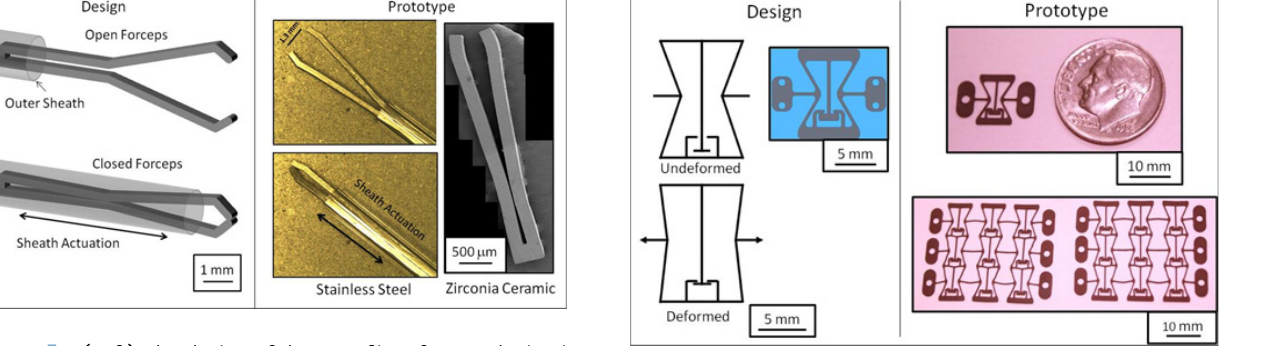
Figure 6. (Left) The design of contact-aided compliant cellular mechanisms is shown in both the undeformed and deformed cases. As the mechanism is deformed, contact occurs in the dash-pot struc- ture, resulting in a distribution of stresses throughout the device, allowing further elastic deformation. The final design is shown in blue. (Right) Optical images of prototype designs of the C3M de- vices, as fabricated by the LM-RIF process are shown for both a single unit cell, and a 3 × 3 cellular array. A US Dime is shown for scale reference. The stainless steel parts demonstrate the ability of the LM-RIF process to fabricate mesoscale compliant mechanism